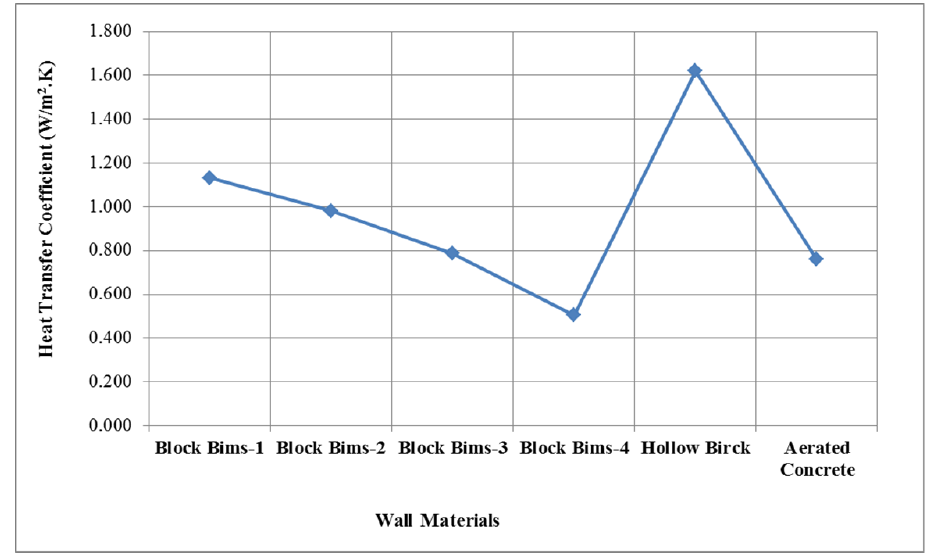
Figure 6. The heat transfer coefficients for uninsulated walls depend on different wall materials.